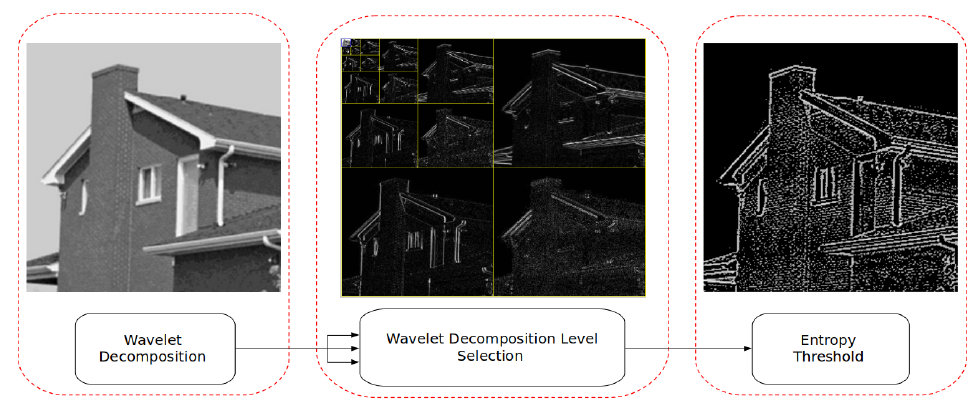
Figure 1. The overview of the proposed